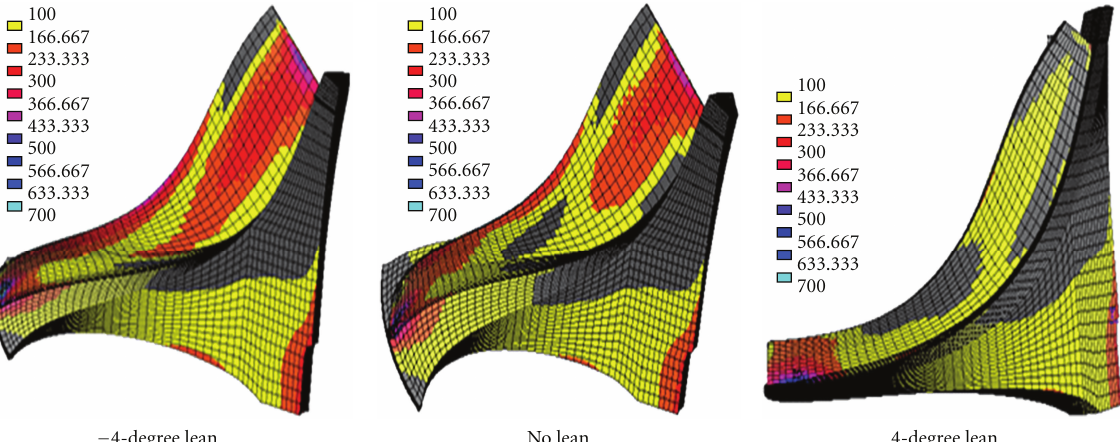
Figure 17: Von Mises stress at the suction side of the wheel.